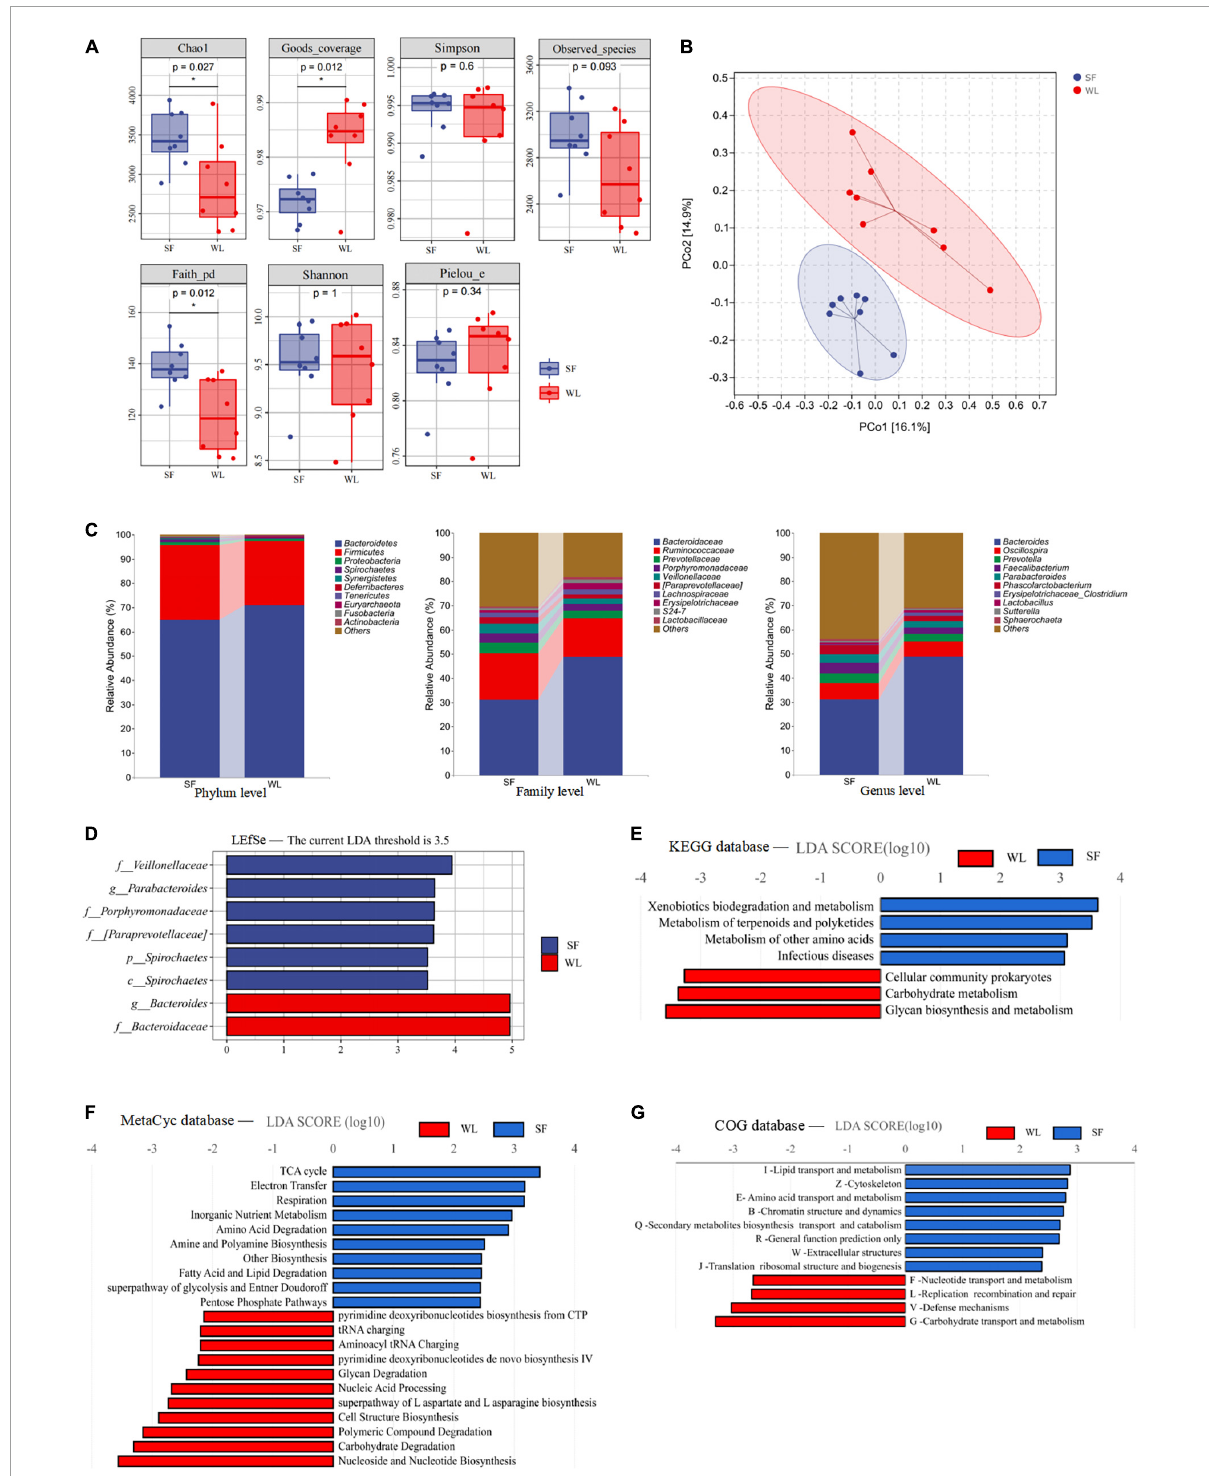
FIGURE2 Cecal microbiome description of WL and SF. (A) Cecal Microbial Alpha Diversity Index Diagram of WL and SF. (B) Principal coordinate analysis (PCoA) based on Bray-Curtis distance, with 95% ellipse confidence. (C) Average relative abundances of dominant bacterial phylum, family and genus. (D) LEfSe analysis with LDA threshold 3.5, and metabolism pathways prediction of the cecal microbiota based on KEGG (E) , MetaCyc (F) , and COG (G) databases. Statistical significance is given as *** P < 0.001; ** P < 0.01; * P < 0.05. Brackets are used to emphasize that this is the official Greengenes database recommended taxonomic information, there may be corrections or improvements to this taxonomic